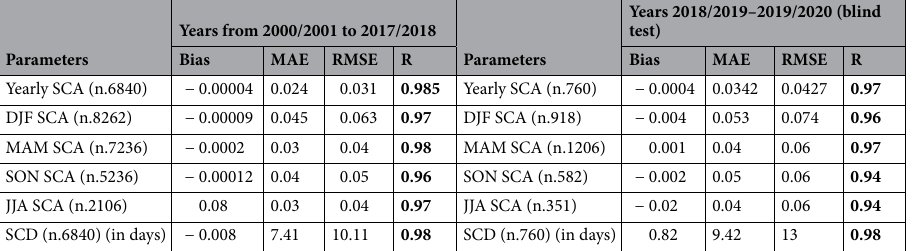
Table 2. Performances of the ANNs for yearly SCA, SCD, SON SCA, DJF SCA, MAM SCA, JJA SCA. For each data set, in parenthesis the number of points used in the evaluation is indicated. Values in bold are significant at 5% level.